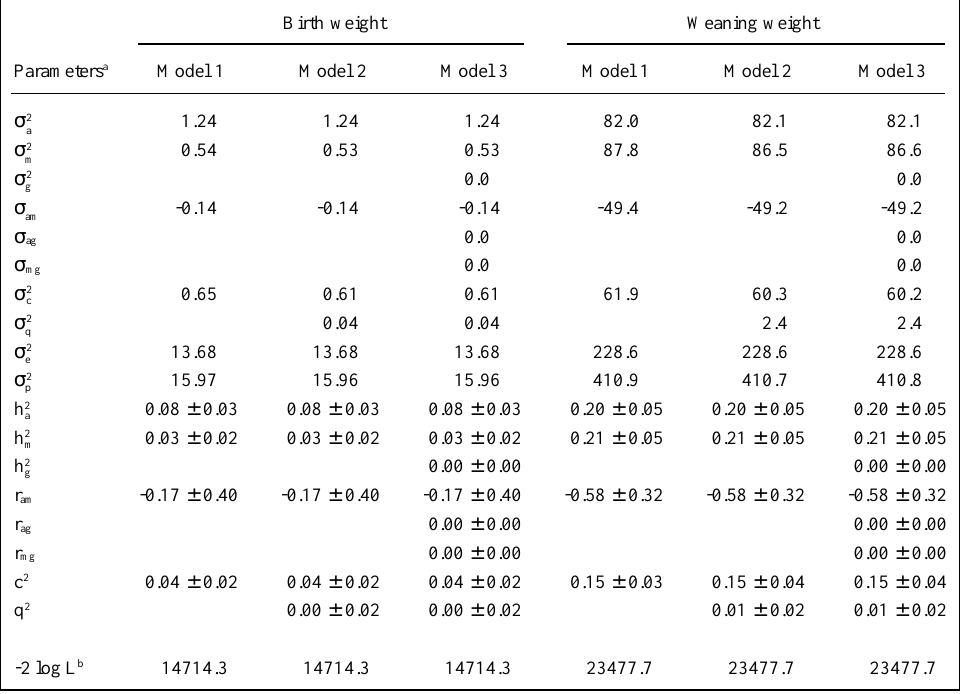
Table II - Estimates of the components of variance and genetic parameters for birth and weaning weights of Gobra cattle. Birth weight Weaning